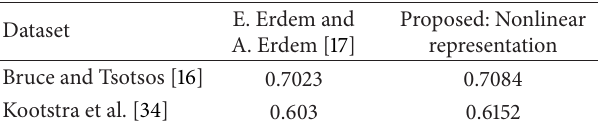
Table 6: sAUC comparison of E. Erdem and A. Erdem [17] and the proposed color based nonlinear